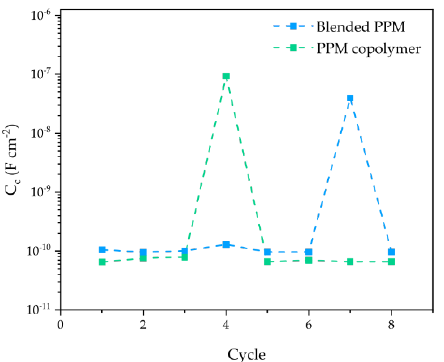
Figure 5. Evolution of the coating capacitance Cc for a 50 µ m PPM copolymer coating (green) and a 50 µ m coating of blended PPM (blue) over ACET cycles. Values are obtained by the fitted EIS spectra carried out at OCP. Dotted lines represent a guide for eye only.